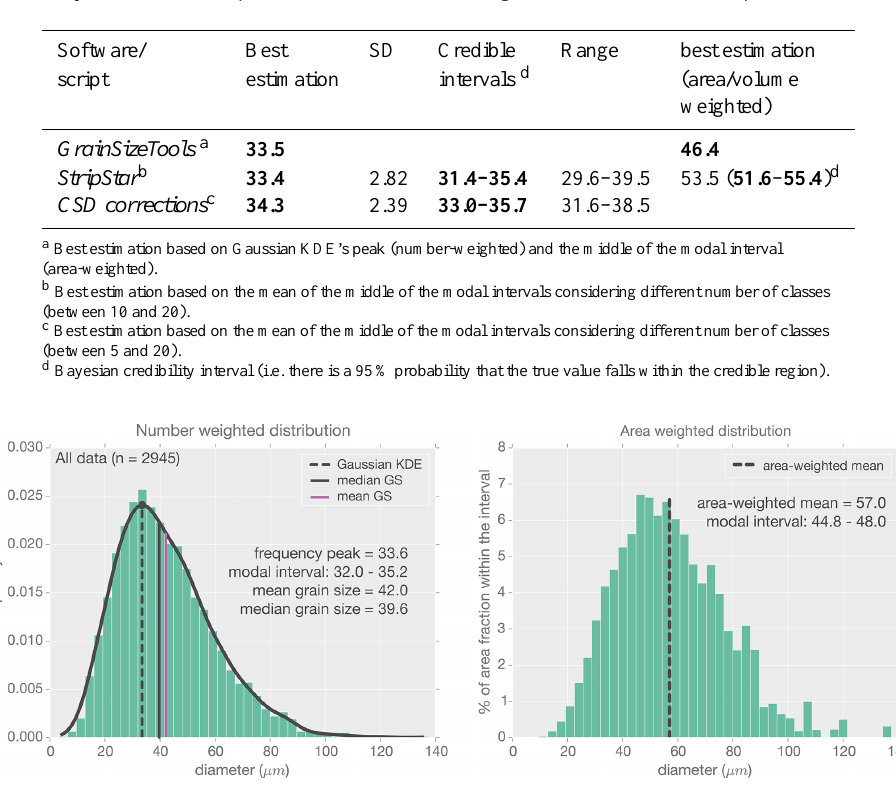
Table 3. Results produced by the different script/software’s considered using the whole data set of sample MAL-05.